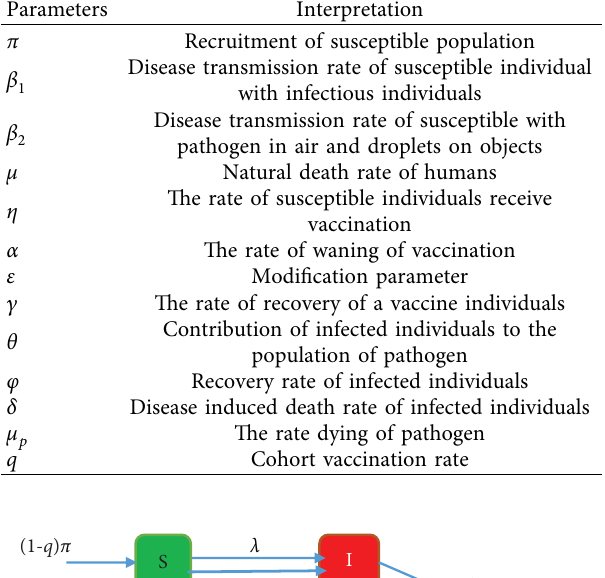
Table 2: Description of parameters of the deterministic model.